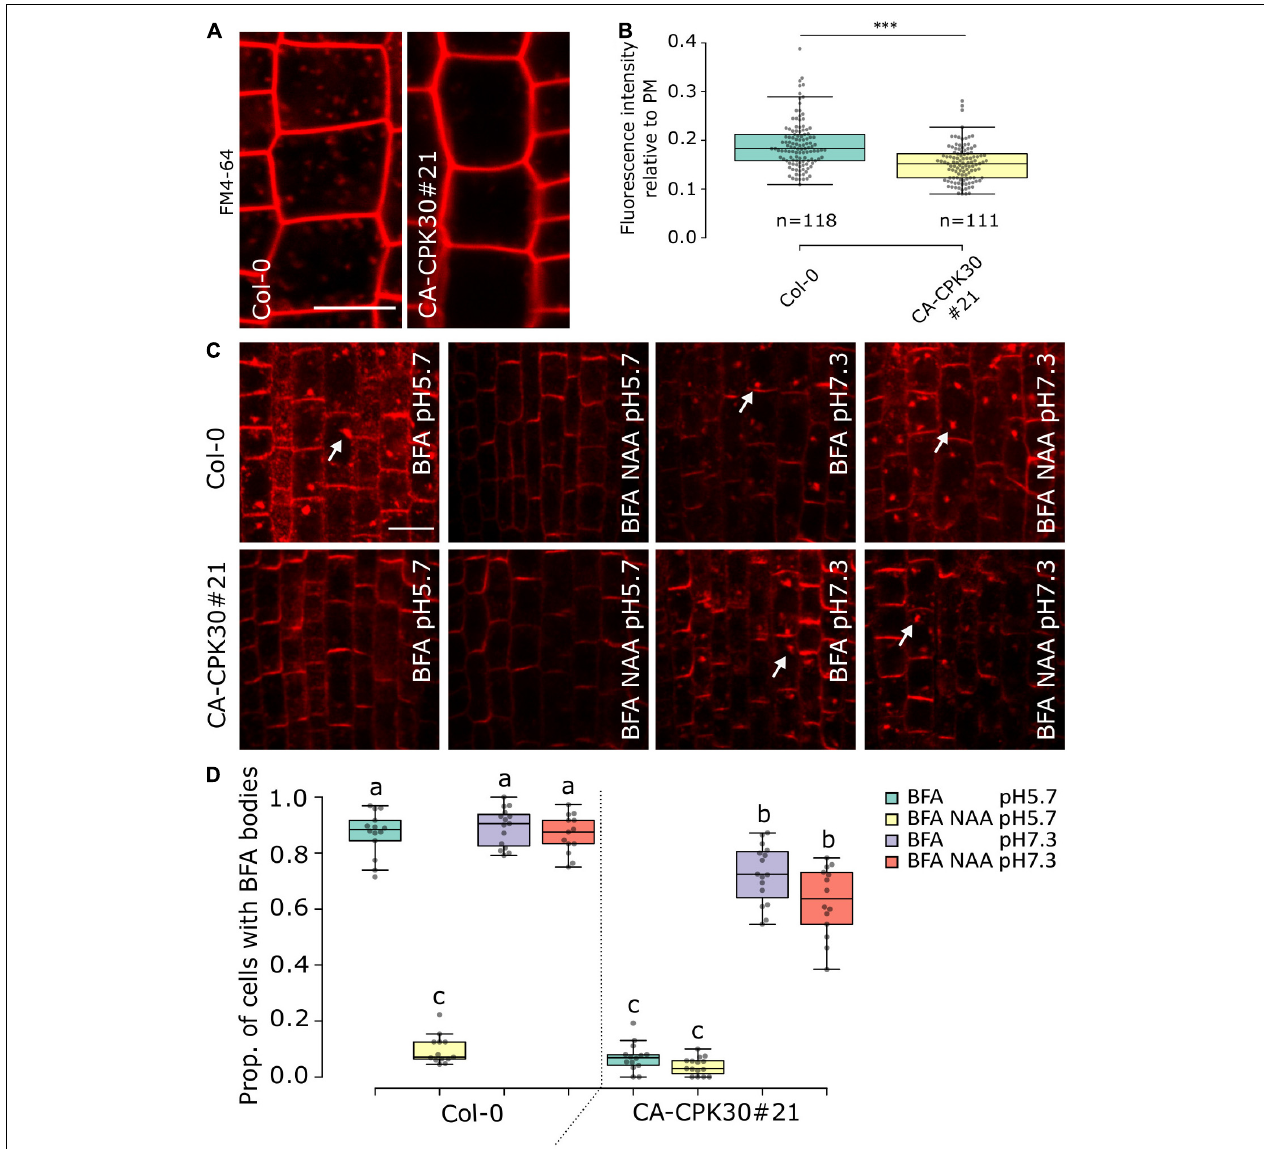
FIGURE 4 | BFA insensitivity in CA-CPK30 depends on the extracellular pH. (A) Representative confocal images of FM4-64 uptake in β -estradiol-treated (1 day, 2.5 µ M) Col-0 and CA-CPK30#21 seedlings in root epidermal cells. The 5-days-old seedlings were pretreated with liquid medium for 20 min, followed by 10 min incubation in liquid medium containing 5 µ M FM4-64. The contrast was equally enhanced in both pictures for illustrational purposes. Measurements were done on the original images without saturation of pixels. (B) Quantification of FM4-64 fluorescence intensity in the cytoplasm relative to the plasma membrane of Col-0 and CA-CPK30#21. Numbers (n) represent the cells analyzed from 11 individual seedlings for each line, over three replicates. Unpaired Student’s t -test; ∗∗∗ P < 0.001. Scale bar = 20 µ m. (C) Whole-mount immunolocalization using anti-PIN1 antibodies in 5 day-old seedling root meristems of β -estradiol treated wild-type (Col-0) and CA-CPK30#21 seedlings that were treated with BFA or BFA/NAA at pH5.7 and at pH 7.3. Seedlings were transferred for 1 day to 2.5 µ M β -estradiol prior to different treatments. Seedlings were incubated in liquid β -estradiol-containing medium with pH 5.7 or pH 7.3 for 30 min then incubated with 25 µ M BFA or combined with 10 µ M NAA in pH 5.7 or pH 7.3 for 1 h. White arrows indicate PIN1 in BFA bodies. Scale bar = 20 µ m. (D) Quantification of the proportion of cells with BFA bodies for treatments described in (C) (for Col-0: n = 14 in BFA, pH5.7; n = 13 in BFA/NAA, pH5.7; n = 15 in BFA, pH7.3; n = 13 in BFA/NAA, pH7.3) and (for CA-CPK30#21: n = 14 in BFA, pH5.7; n = 15 in BFA/NAA, pH5.7; n = 16 in BFA, pH7.3; n = 14 in BFA/NAA, pH7.3), three replicates. For the box plots, significant differences ( P ≤ 0.05, Wald-type test) are indicated by different lowercase letters. The central line indicates the median, the bottom and top edges of